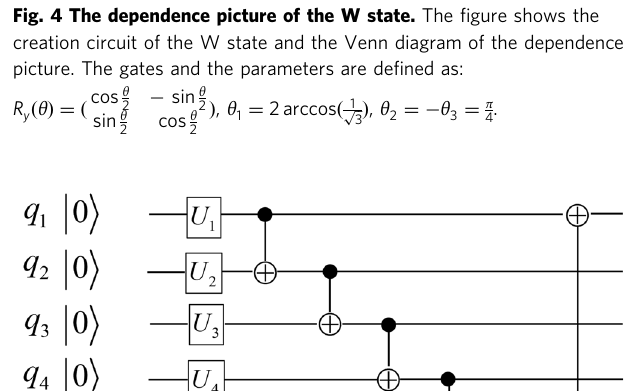
Fig. 6 The 2nd example of the hardware-ef fi cient ansatz. The fi gure shows the quantum circuit of one layer of the hardware-ef fi cient ansatz in ref. 34 U 1 through U 6 are 1-qubit unitaries applied to the qubits q 1 through q , respectively. The CNOT gate layer then copies the unitary dependencies 6 around the qubits. The fi nal unitary dependence picture as described in Eq. (11) shows the qubits are more independent in manipulations and measurement statistics.